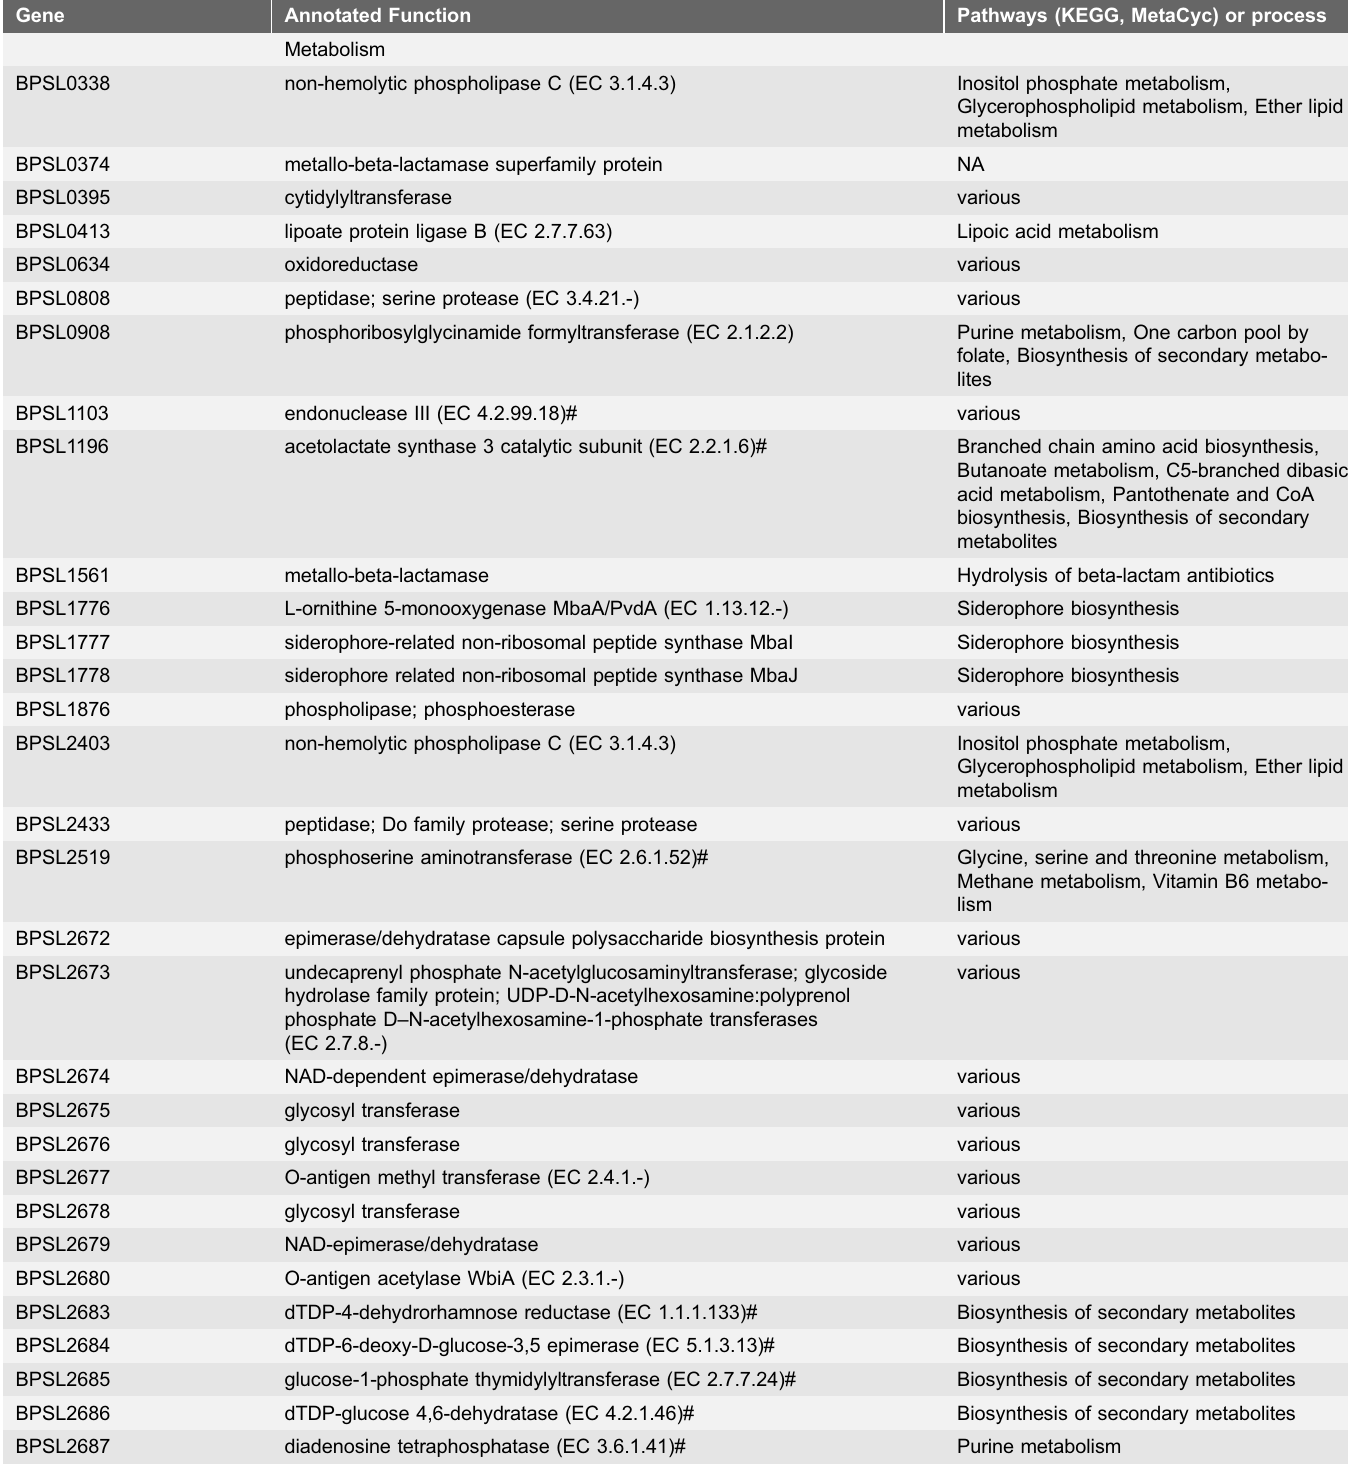
Table 7. Virulence genes in B. pseudomallei K96243, 1106a and MSHR668 genomes with metabolic and regulatory functions.